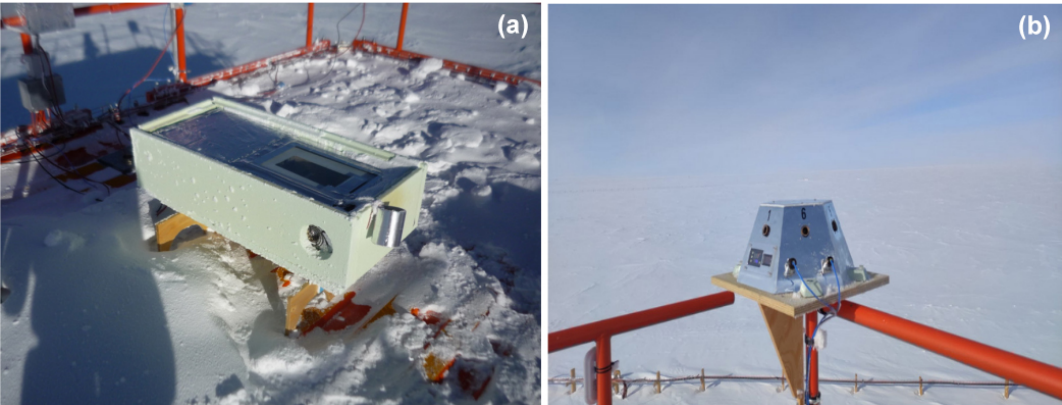
Figure 3. (a) ICE-CAMERA mounted on the roof of the PHYSICS shelter. (b) HALO-CAMERA installed on the handrail at the edge of the